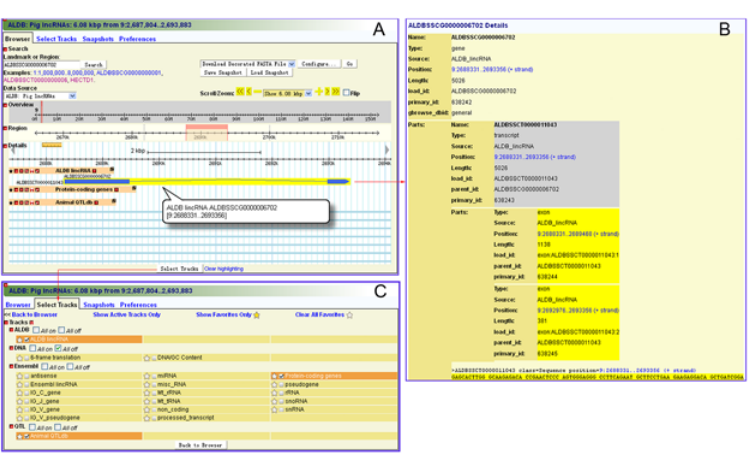
Fig 3. Visualization of genome annotation using GBrowse. ( A ) Users can search and browse features using GBrowse. ( B ) Detail page of a gene. ( C ) Tracks in GBrowse.